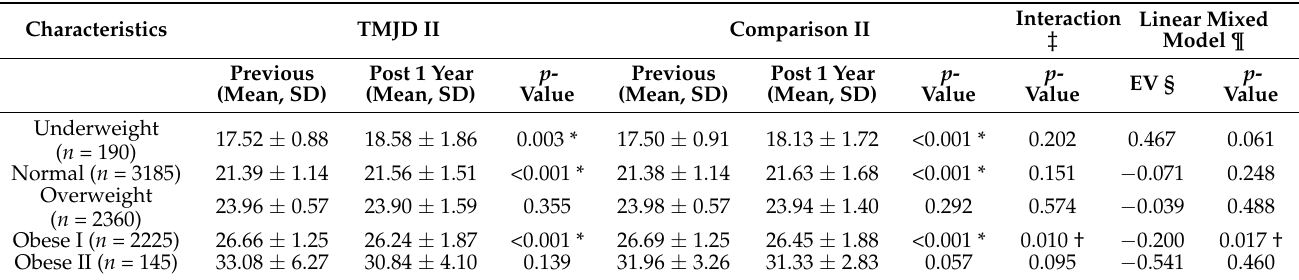
Table 5. Differences in mean BMI between pre- and 2-year-post-study of TMJD in TMJD II and comparison II group according to